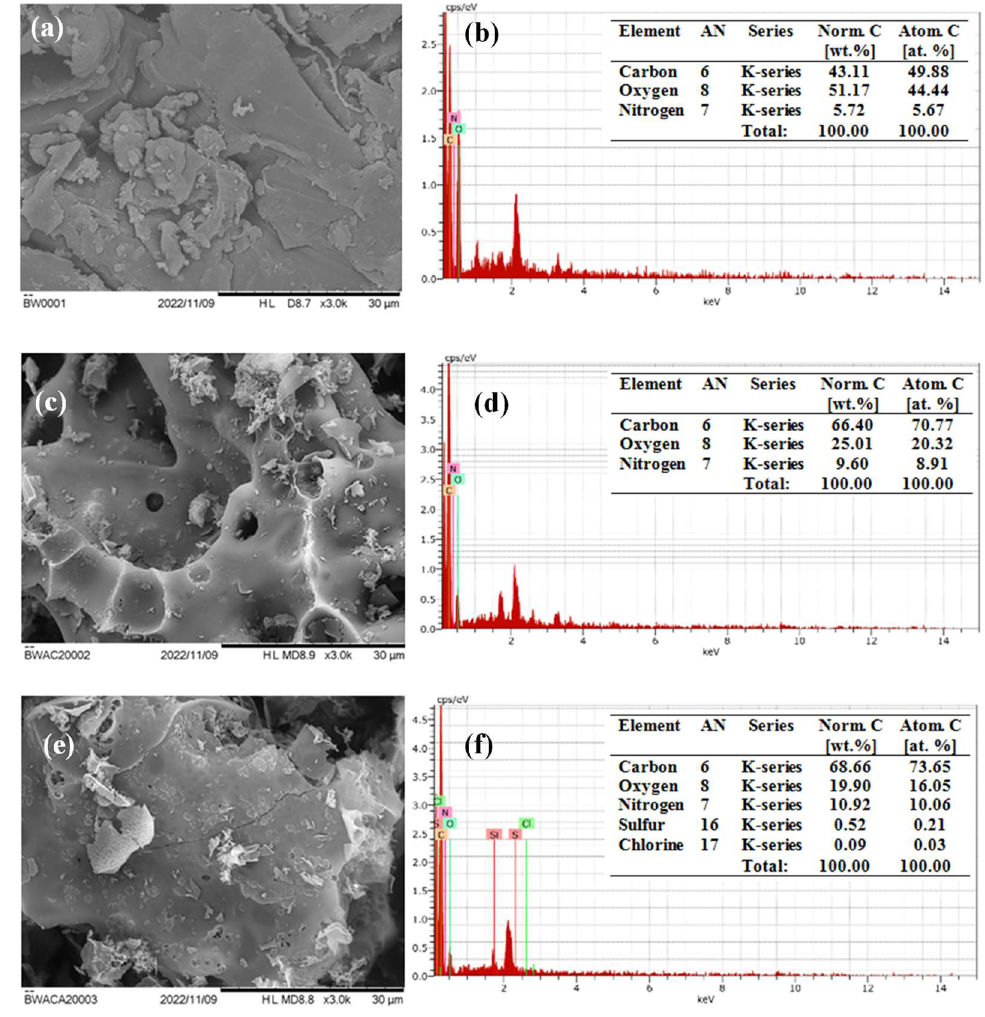
Figure 1. SEM and EDX images of ( a , b ) BW, ( c , d ) BWAC, and ( e , f ) BWAC after MB adsorption.